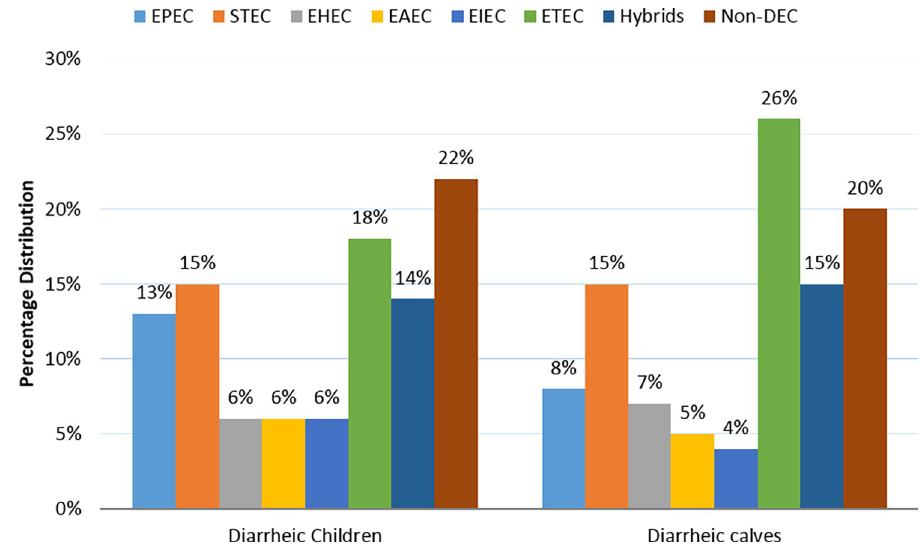
Fig 1. Distribution of DEC pathotypes among diarrheic children and